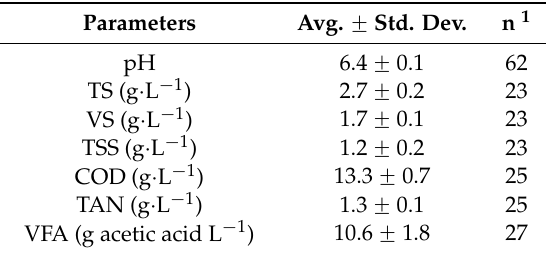
Table 2. Characteristics of effluent from acidogenic digester that is used for struvite precipitation and biochemical methane potential